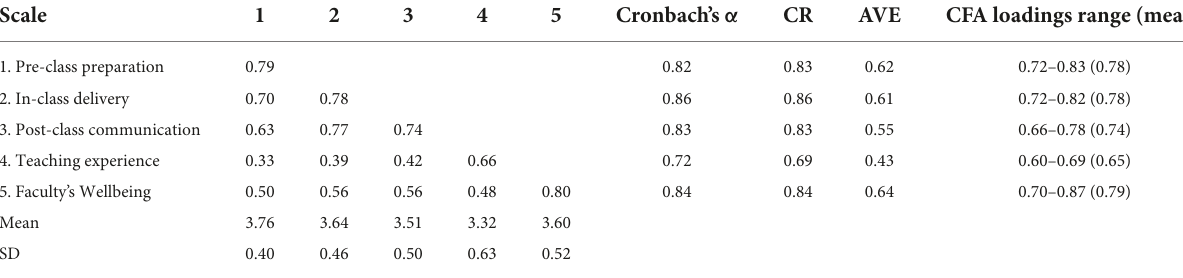
TABLE 1 Correlation matrix, reliability, validity, and descriptive statistics ( N =